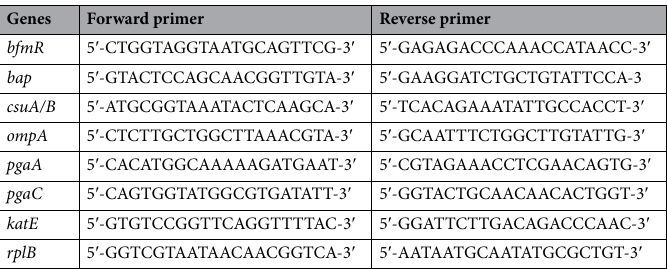
Table 3. List of primers used for qPCR